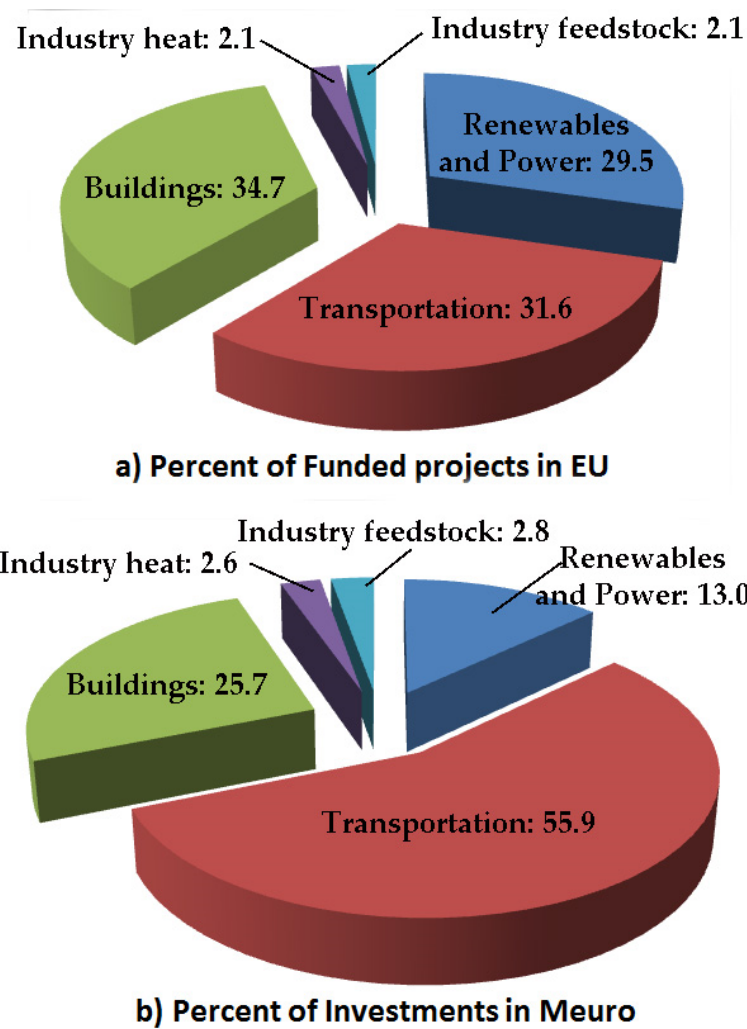
Figure 14. ( a ) funded projects in EU, ( b ) investments in M€.